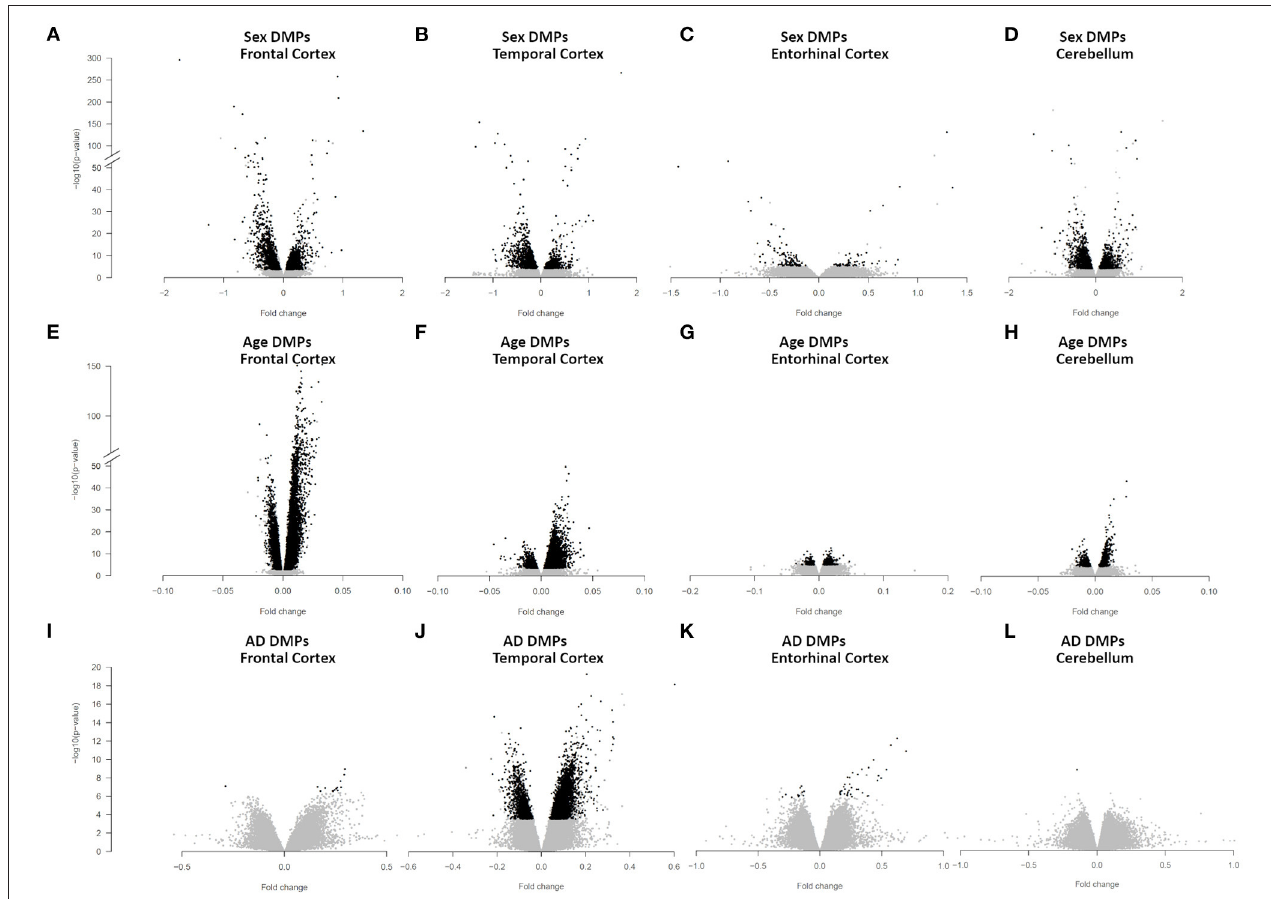
FIGURE 1 | Sex-, age-, and AD-associated epigenetic changes in the four brain regions. Volcano plots of -log10( P -value) against effect sizes, resulting from the meta-analysis of: (i) sex-associated DMPs in FC (A) , TC (B) , ERC (C) , and CRB (D) ; (ii) age-associated DMPs in FC (E) , TC (F) , ERC (G) , and CRB (H) ; (iii) AD-associated DMPs in FC (I) , TC (J) , ERC (K) , and CRB (L) . Significant probes (BH-corrected p -value < 0.01) are colored in